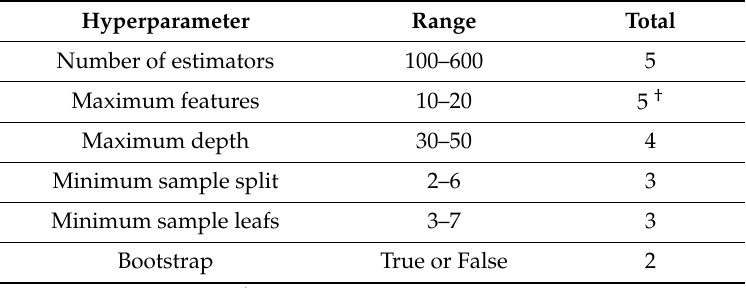
Table 4. Hyperparameter grid used for a 5-fold